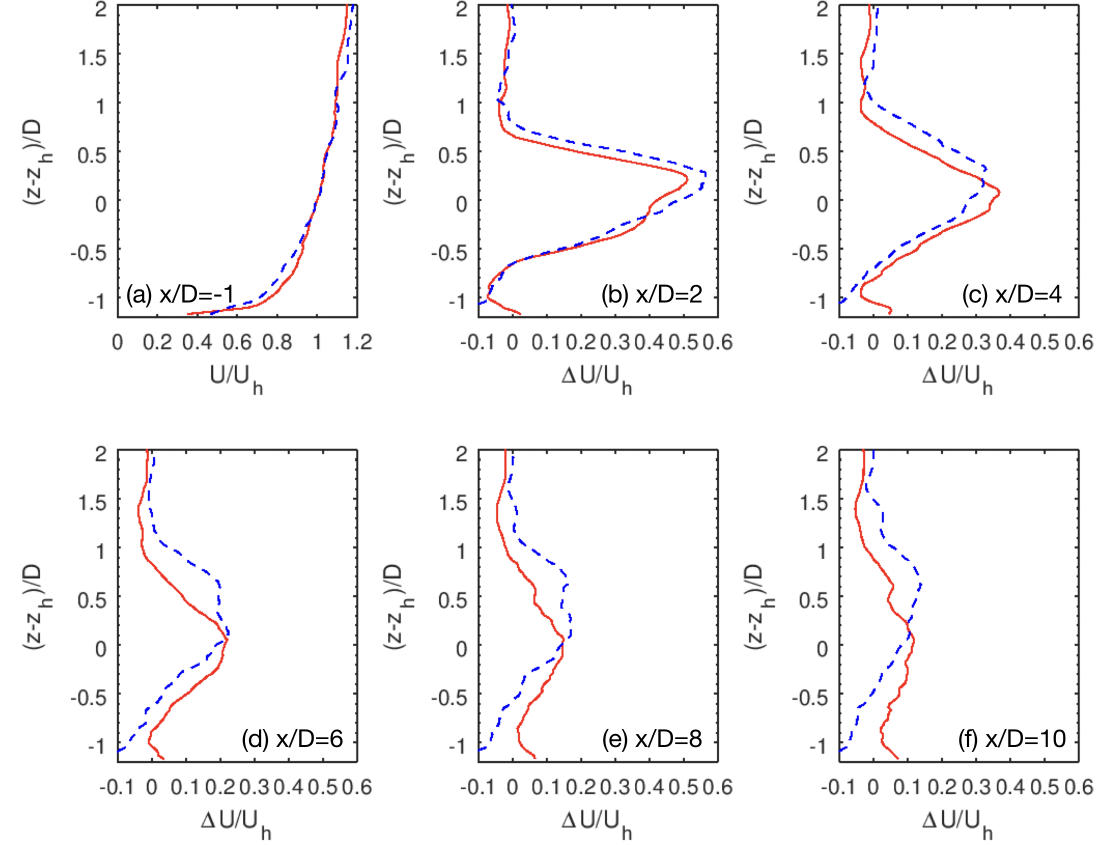
Figure 8. ( a ) Vertical profiles of time-averaged downwind velocity at 1 D upwind of the turbine; ( b – f ) Vertical profiles of time-averaged velocity deficit at different locations downwind of the turbine. Red lines: T80; Blue lines: